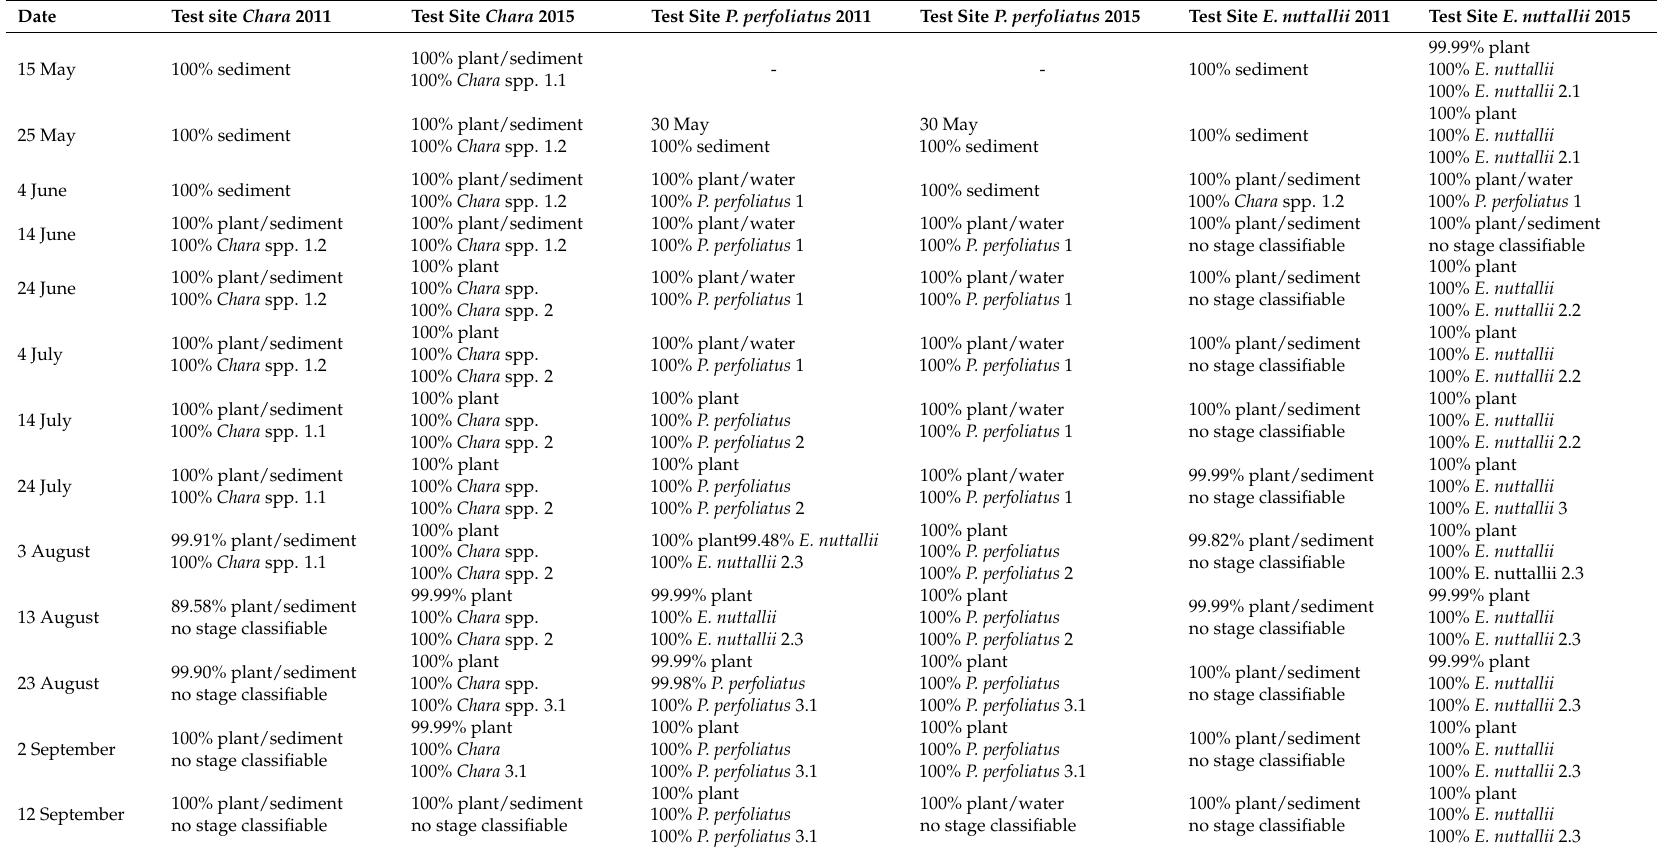
Table 1. Results of the stepwise classification after Wolf [60] for Chara spp., E. nuttallii and P. perfoliatus